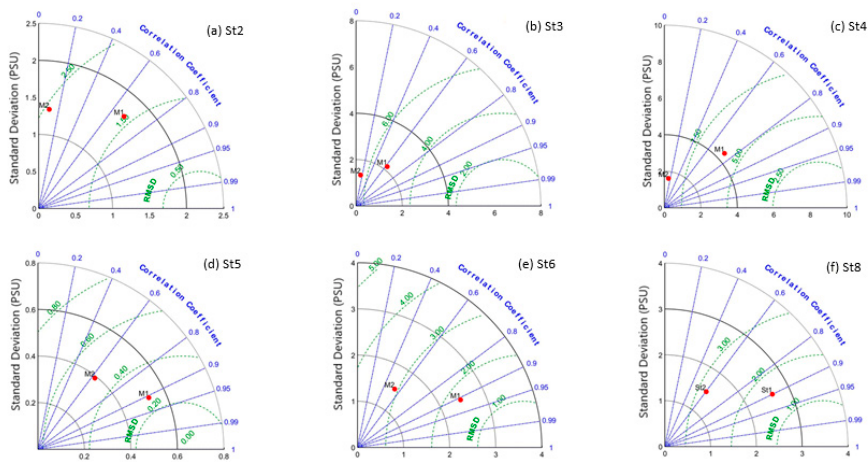
Figure 18. Taylor diagrams for SC1 (M1) and SC2 (M2), for salinity and the lagoon stations: ( a ) St1, ( b ) St3, ( c ) St4, ( d ) St5, ( e ) St6 and ( f ) St8.